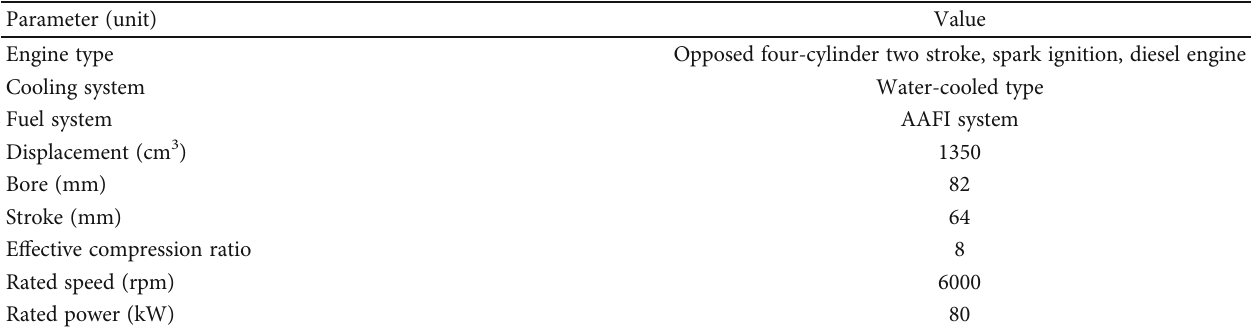
Table 4: Engine main parameters.